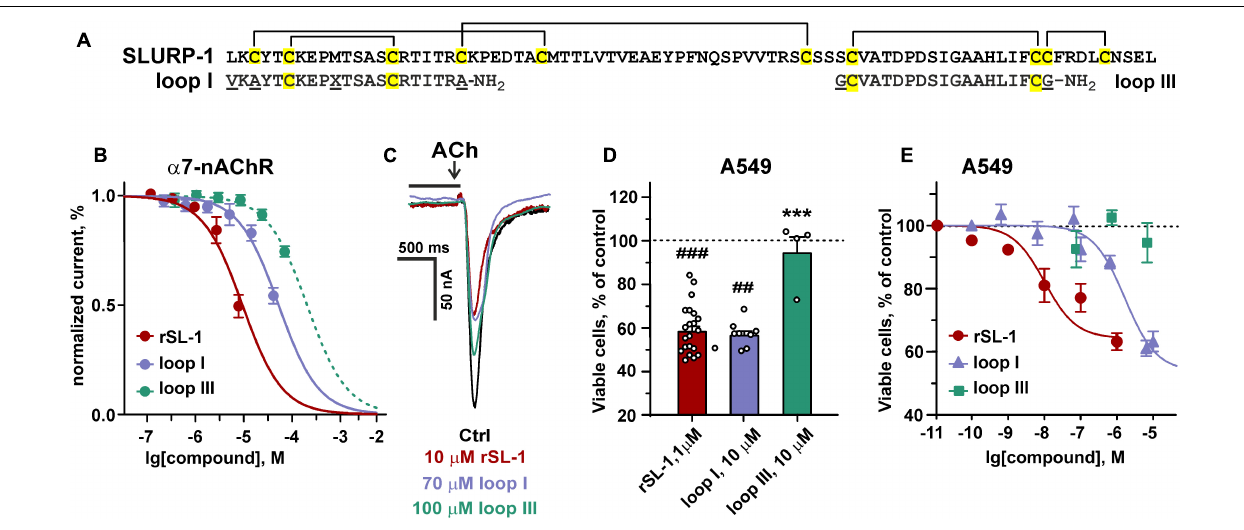
FIGURE 5 | Design and activity of peptides, mimicking the SLURP-1 loops I and III. (A) Amino acid sequence alignment of rSLURP-1 and the synthetic peptides “loop I” and “loop III.” Cys residues are shown by yellow. Disulfide bonds are shown by brackets. (B) The dose-response curves for the inhibition of ACh-evoked currents at α 7-nAChRs expressed in X. laevis oocytes by rSLURP-1 and synthetic peptides. The data are normalized to the peak amplitude of current recorded without compounds application (100%) and presented as mean ± SEM ( n = 4–6 oocytes for each compound). The standard slope (nH = 1) inhibition equation was fitted to normalized data. (C) Representative responses to 100 ms pulses of 100 µ M ACh recorded in absence and presence of rSLURP-1, “loop I” and “loop III” peptides. The period of oocyte pre-incubation with compounds is shown by horizontal bars above current traces (not in the timescale), the application of ACh is shown by arrow. (D,E) Antiproliferative activity of rSLURP-1, and “loop I” and “loop III” peptides in A549 cells upon 48 h incubation according to WST-1 test. Data are presented as % of control (untreated cells, dashed line) ± SEM ( n = 4–22). ## ( p < 0.01) and ### ( p < 0.001) indicate significant difference from the control by one-sample t -test. *** ( p < 0.001) indicates significant difference from the “rSLURP-1” group by one-way ANOVA/Dunnett’s